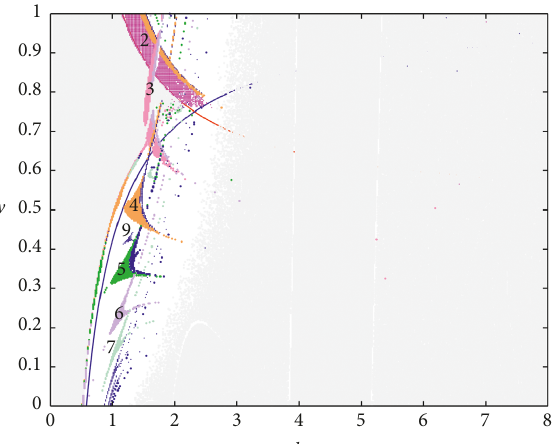
Figure 5: The diagram of 2D bifurcation. It is plotted in the ( k, ω ) − plane showing the regions where different period cycles are born using the values a � 1 and c � 0 .